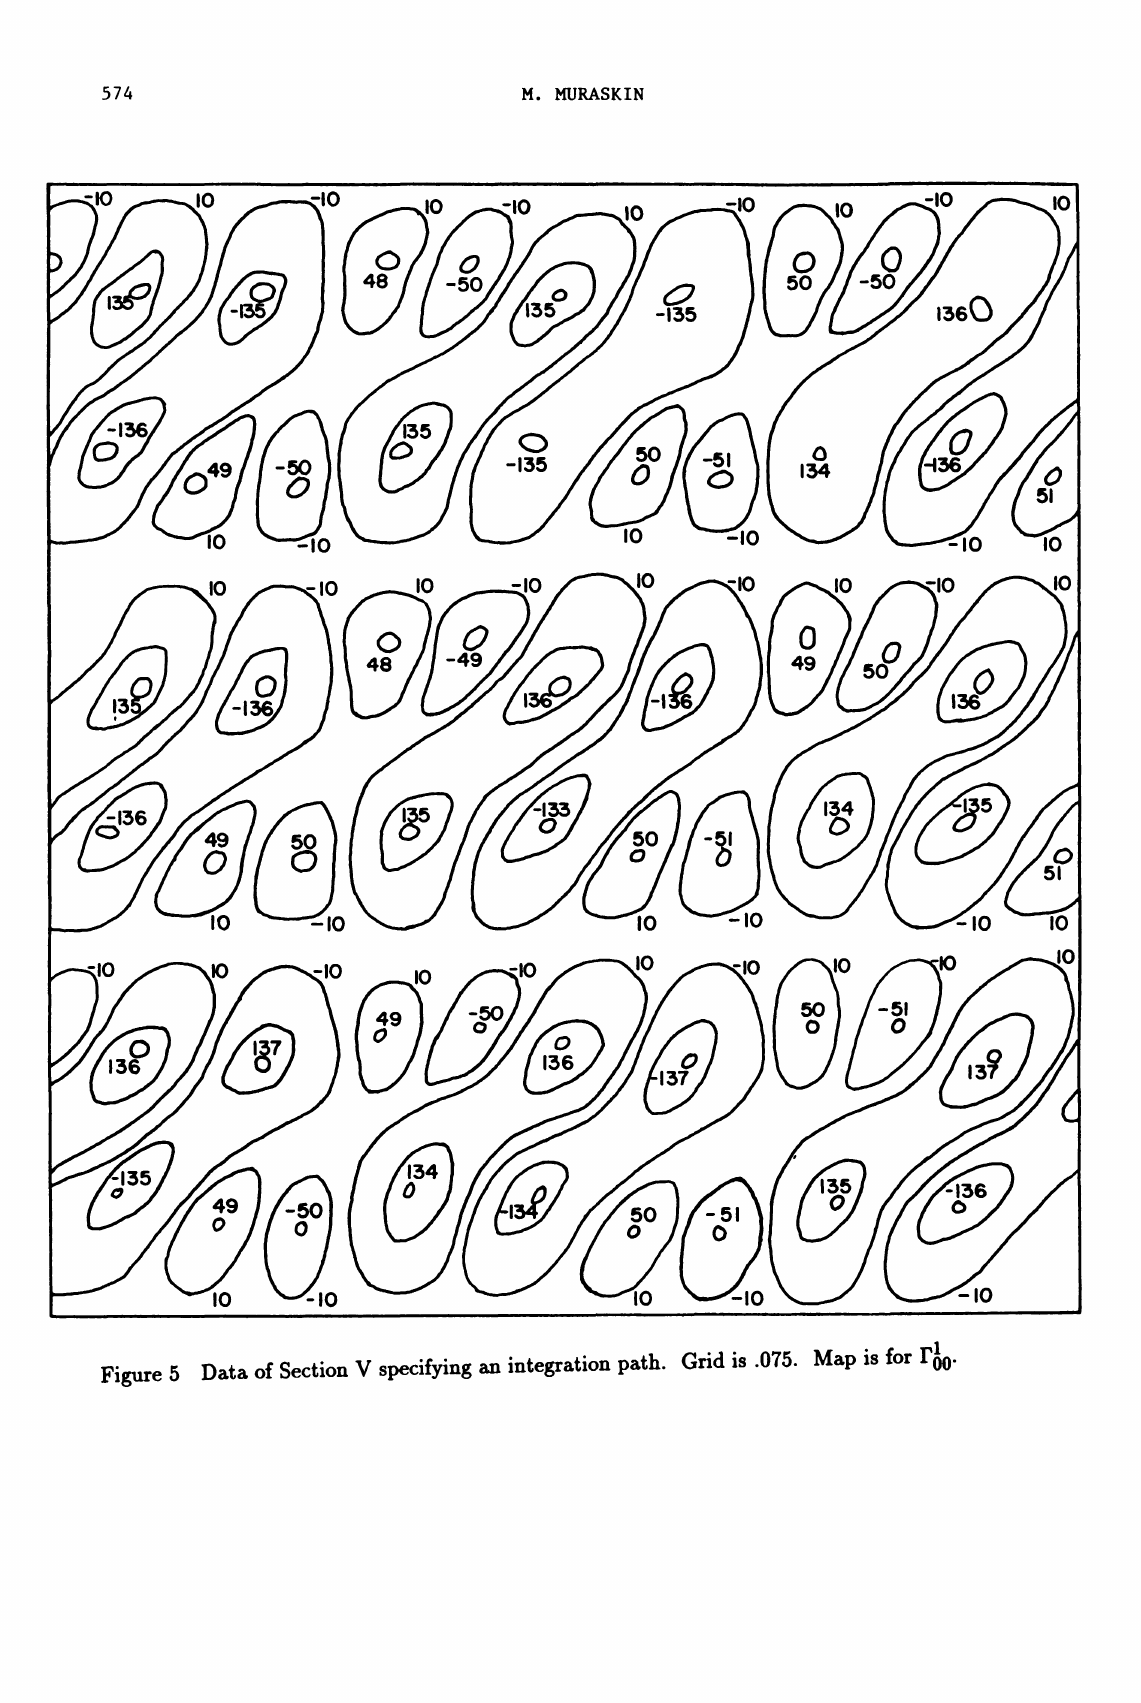
integration path. Grid is .075. Map is for Figure 5 Data of Section V specifying an